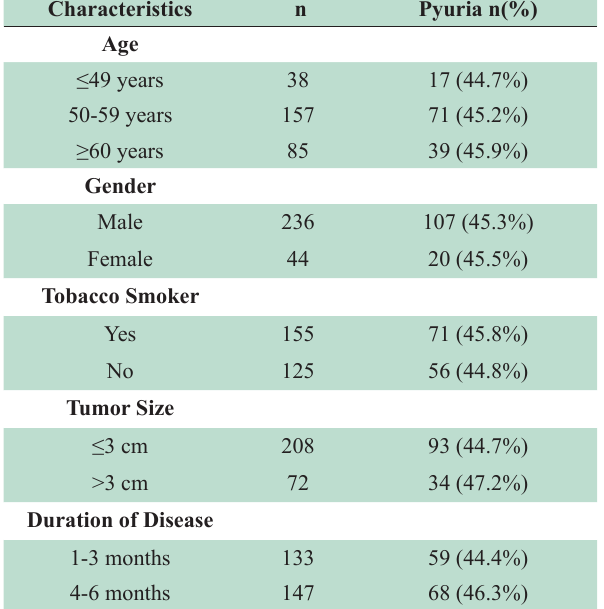
Table-II: Frequency of Pre-operative Pyuria across various Subgroups n=280.